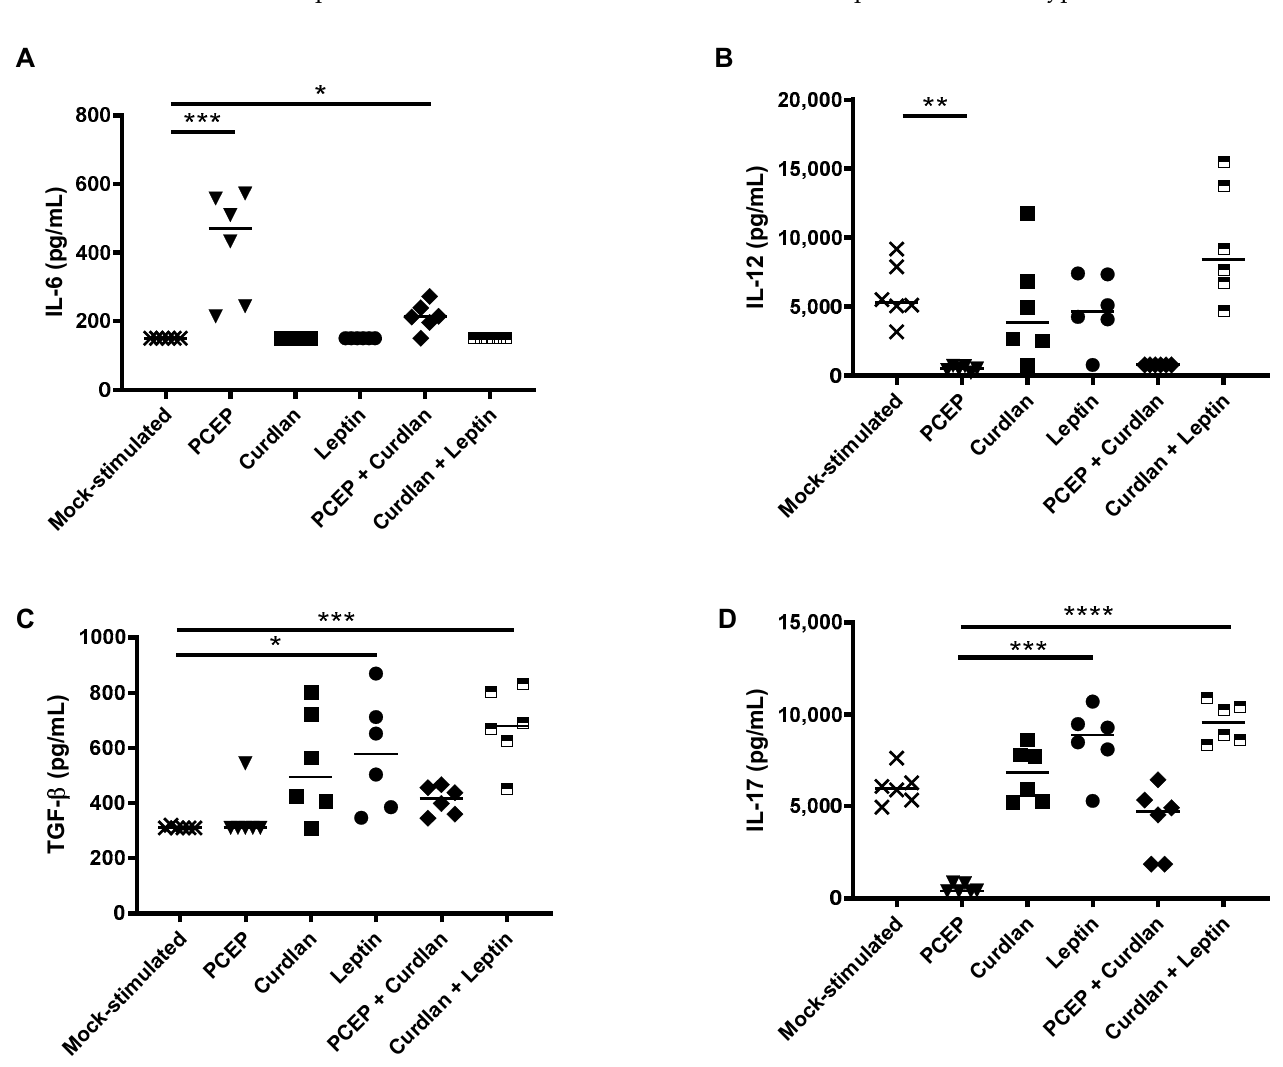
Figure 3. Cytokine expression in murine muscle cells harvested after injection. BALB/c mice were mock-injected with saline or injected (25 µ L per thigh) with PCEP (50 µ g/mL), Curdlan (10 µ g/mL), Leptin (10 µ g/mL), PCEP+Curdlan, and Curdlan+Leptin. Muscle cells were excised and homogenated 48 h post injection and cytokine concentration was analyzed by ELISA for ( A ) IL-6, ( B ) TGF β , ( C ) IL-12, and ( D ) IL-17 (pg/mL). Values were calculated with respect to the ELISA Table 150. 310, 3120, and 1870 pg/mL, respectively. Data shown are presented as the mean of duplicate titres for individual biological replicates and the horizontal line represents the median value for the group. Statistical analysis was performed by one-way ANOVA and the differences between the treatments were compared by Kruskal–Wallis and Dunn’s multiple-comparison tests. Significant differences are depicted as follows: * p < 0.05, ** p < 0.01, *** p < 0.001, **** p <